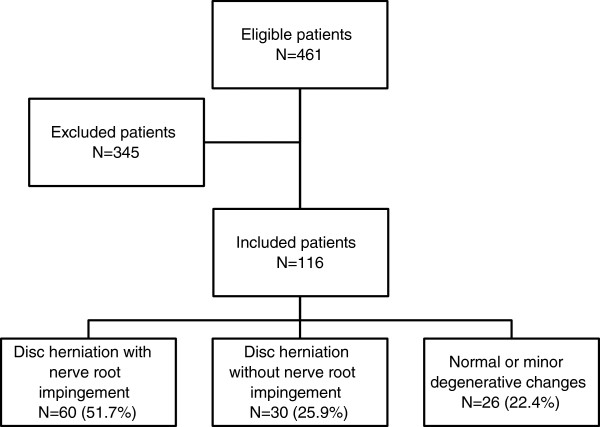
Flowchart showing number of eligible and excluded patients, and results from MRI or CT in the 116 included patients.